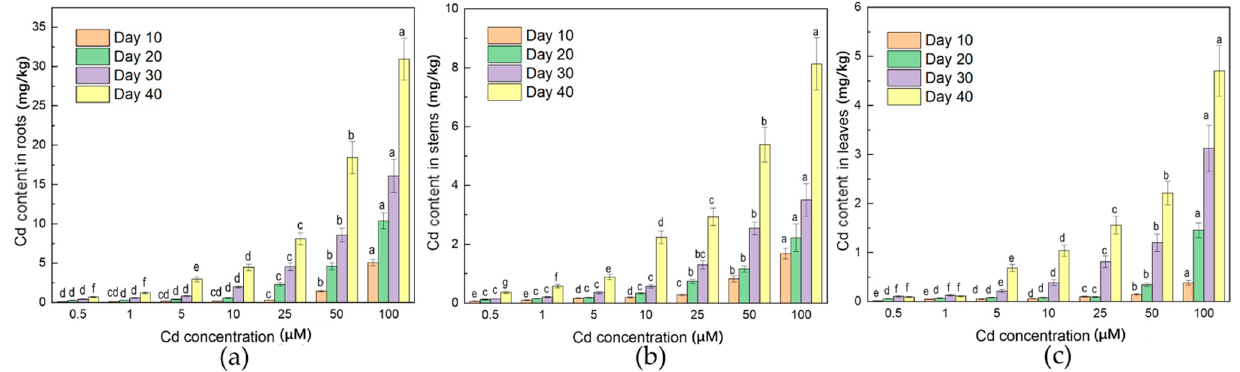
Figure 3. Fresh weight Cd content of A. selengensis after treatment with different concentrations of Cd, ( a ) root, ( b ) stem, ( c ) leaf. The results are means ± SD ( n = 3), lower letters mean significant differences ( p < 0.05) between different Cd concentrations at the same treatment time.